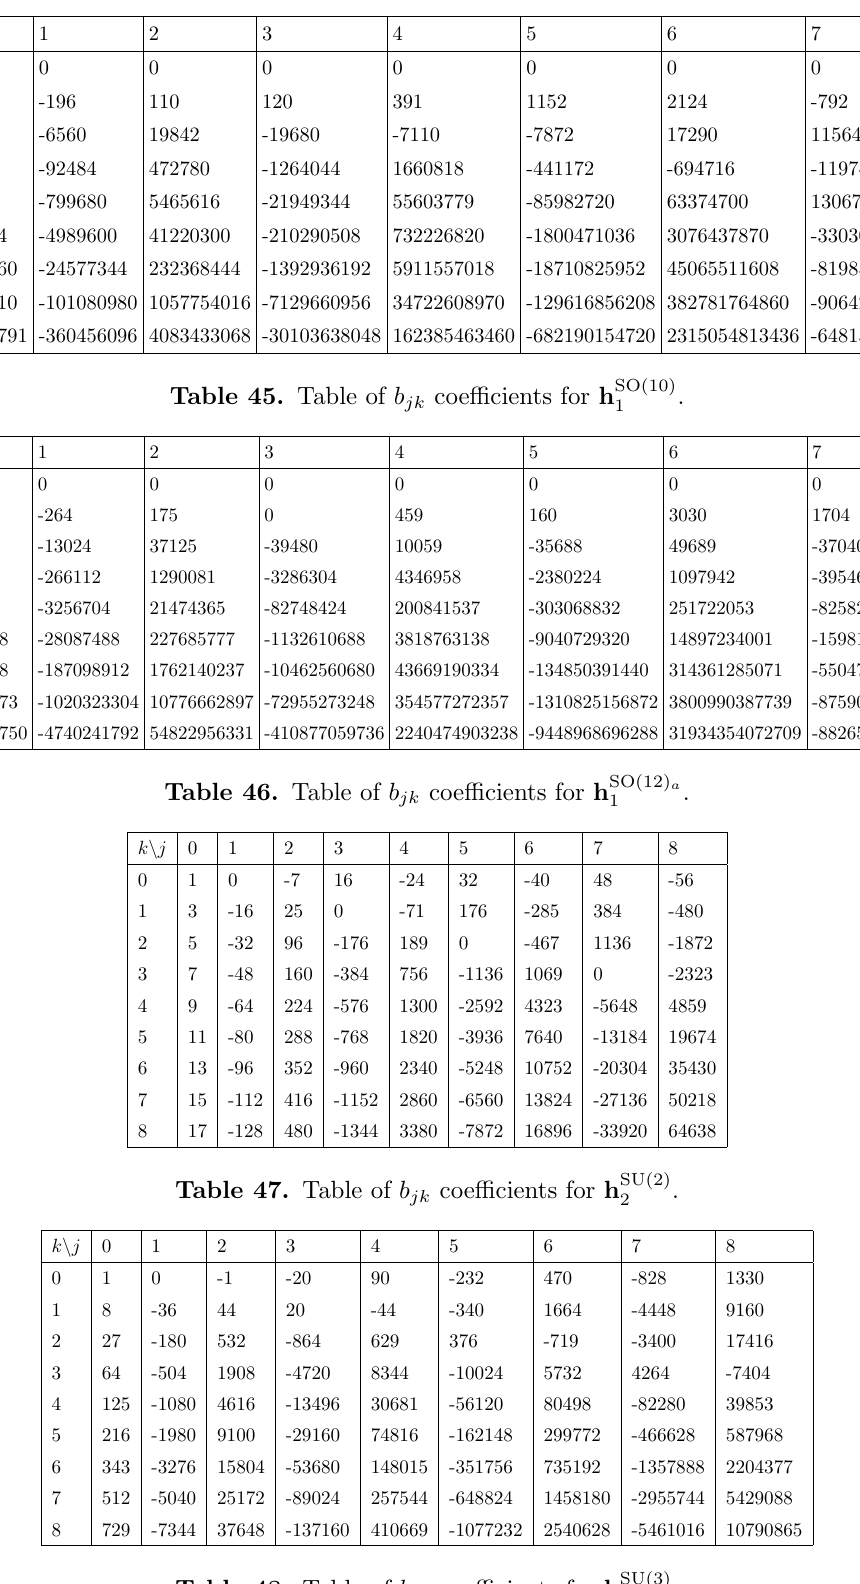
Table 48. Table of b jk coe(cid:14)cients for h SU(3)